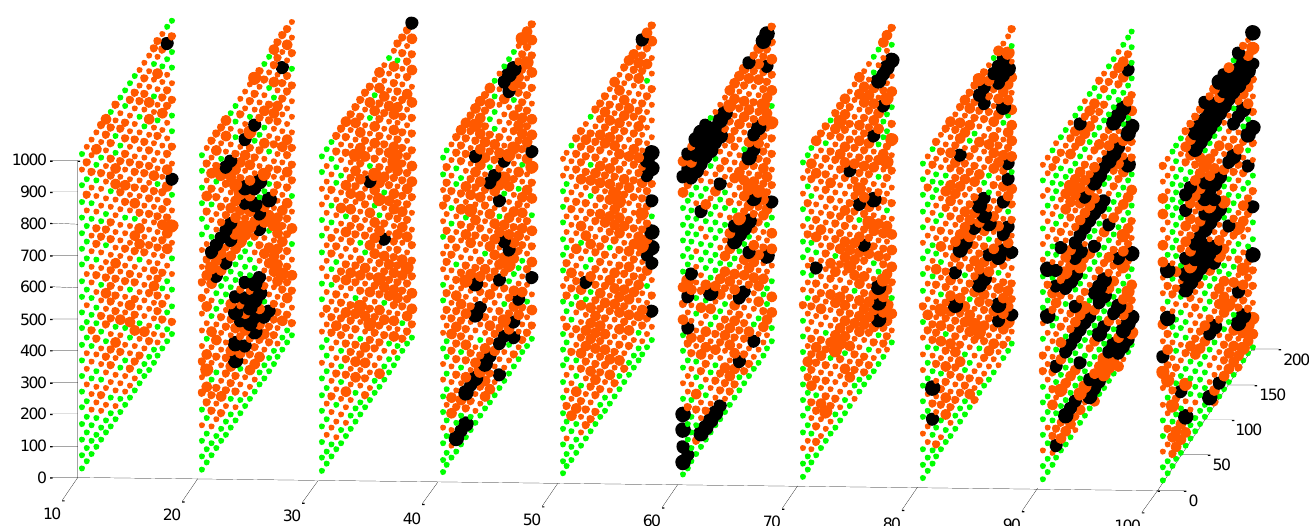
c on EEACL26 images. Along with the bottom points, irregular poor accuracies unexpectedly exist at the middle and upper points as well. Fig. 7. Performance 28